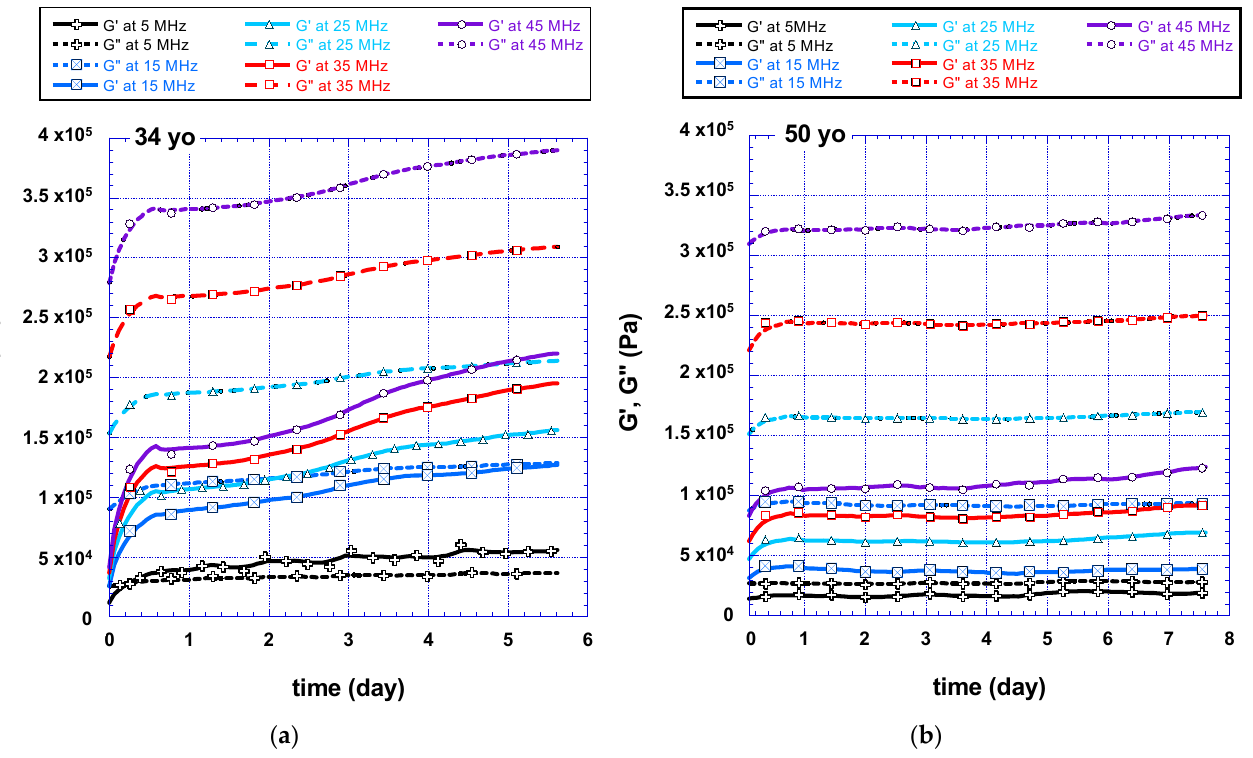
Figure 4. Typical evolutions of 𝐺’ (plain lines) and 𝐺” (dashed lines) on a mesoscopic scale while skin explants were alive: ( a ) from a 34-year-old donor; ( b ) from a 50-year-old donor.